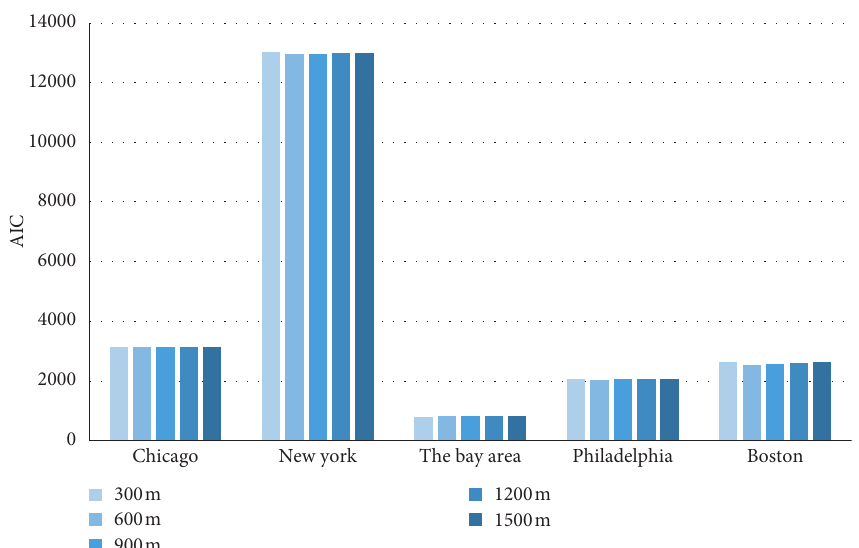
Figure 8: Negative binomial regression result of five different catchment